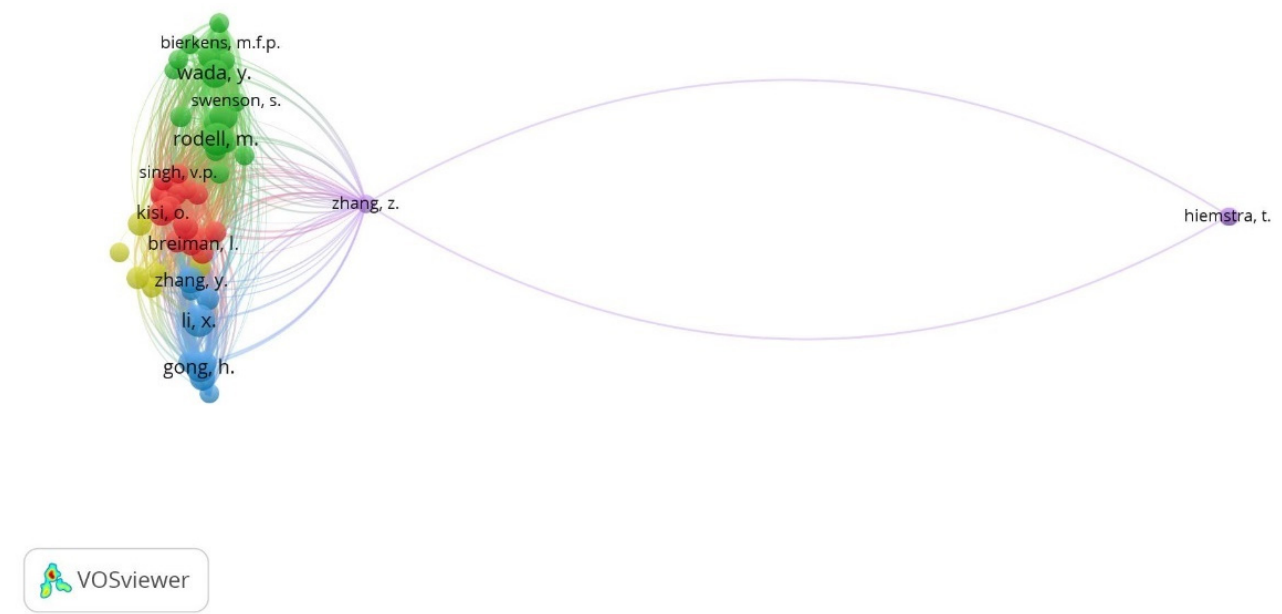
Figure 10. Co-citation of authors. The colors represent clusters.